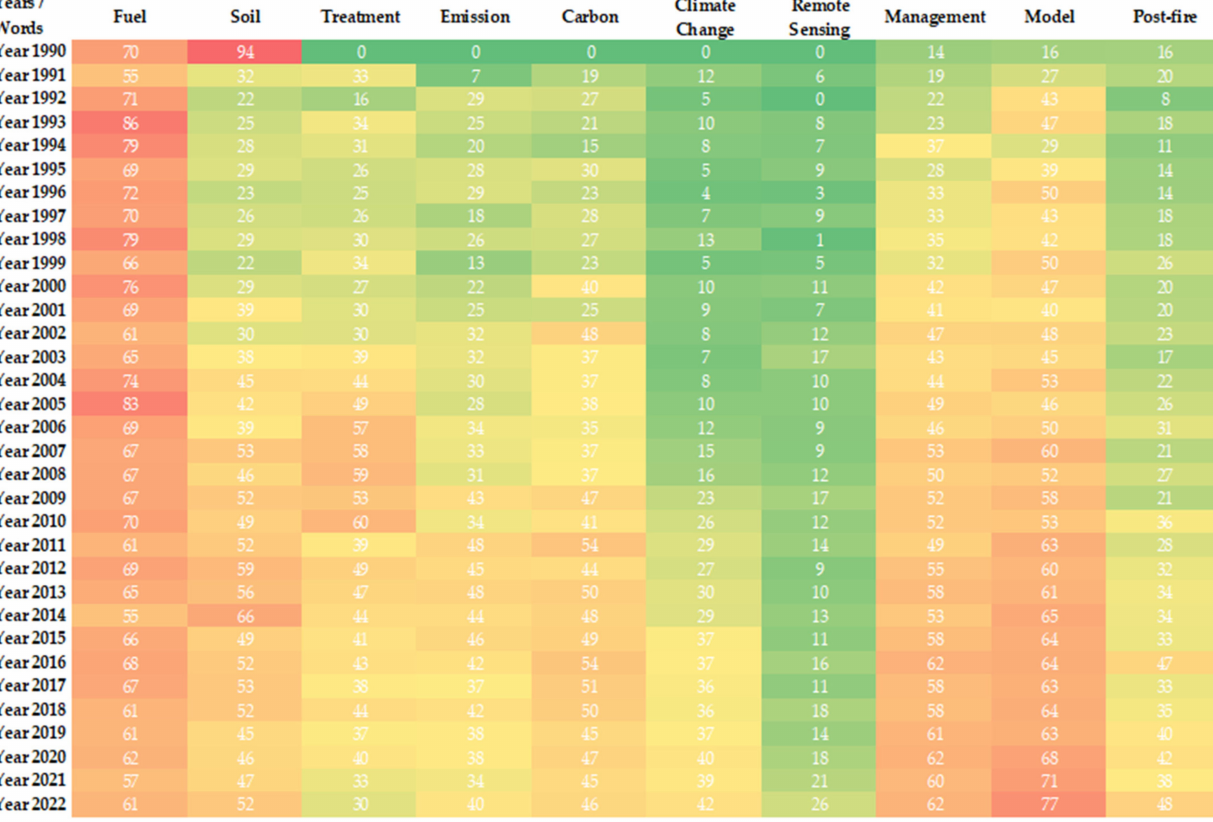
Figure 7. Heatmap of word mean importance weights ( × 10 − 2 ) by